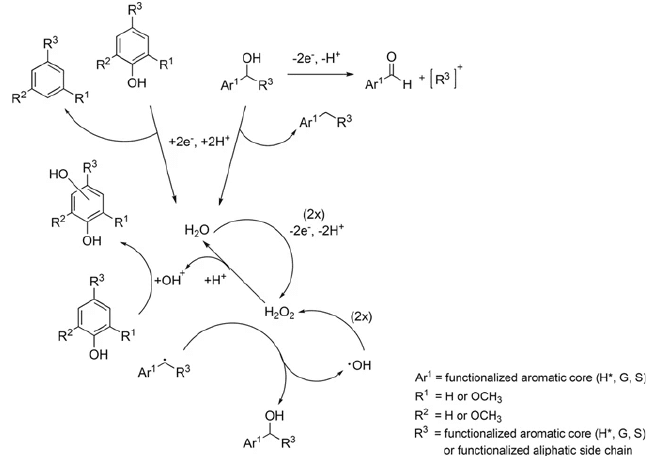
Figure 2. Schematic representation of electrochemical lignin degradation mediated by H 2 O 2 . The number of equivalent of raw materials required are given in the parenthesis. (H*), (G), and (S) represent 4 ‐ hydroxybenzyl, 3 ‐ methoxy ‐ 4 ‐ hydroxybenzyl, and 3,5 ‐ dimethoxy ‐ 4 ‐ hydroxybenzyl, respectively. Reprinted from permission from Ref. [62]. Copyright (2017) Springer Nature.